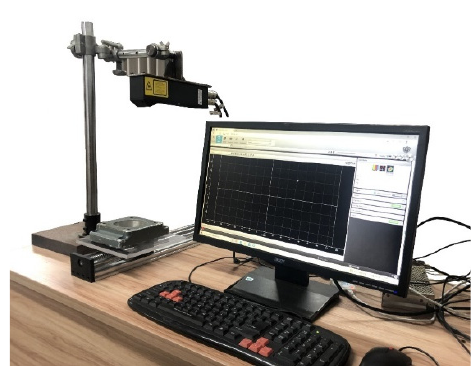
Figure 8. Laser-scanning